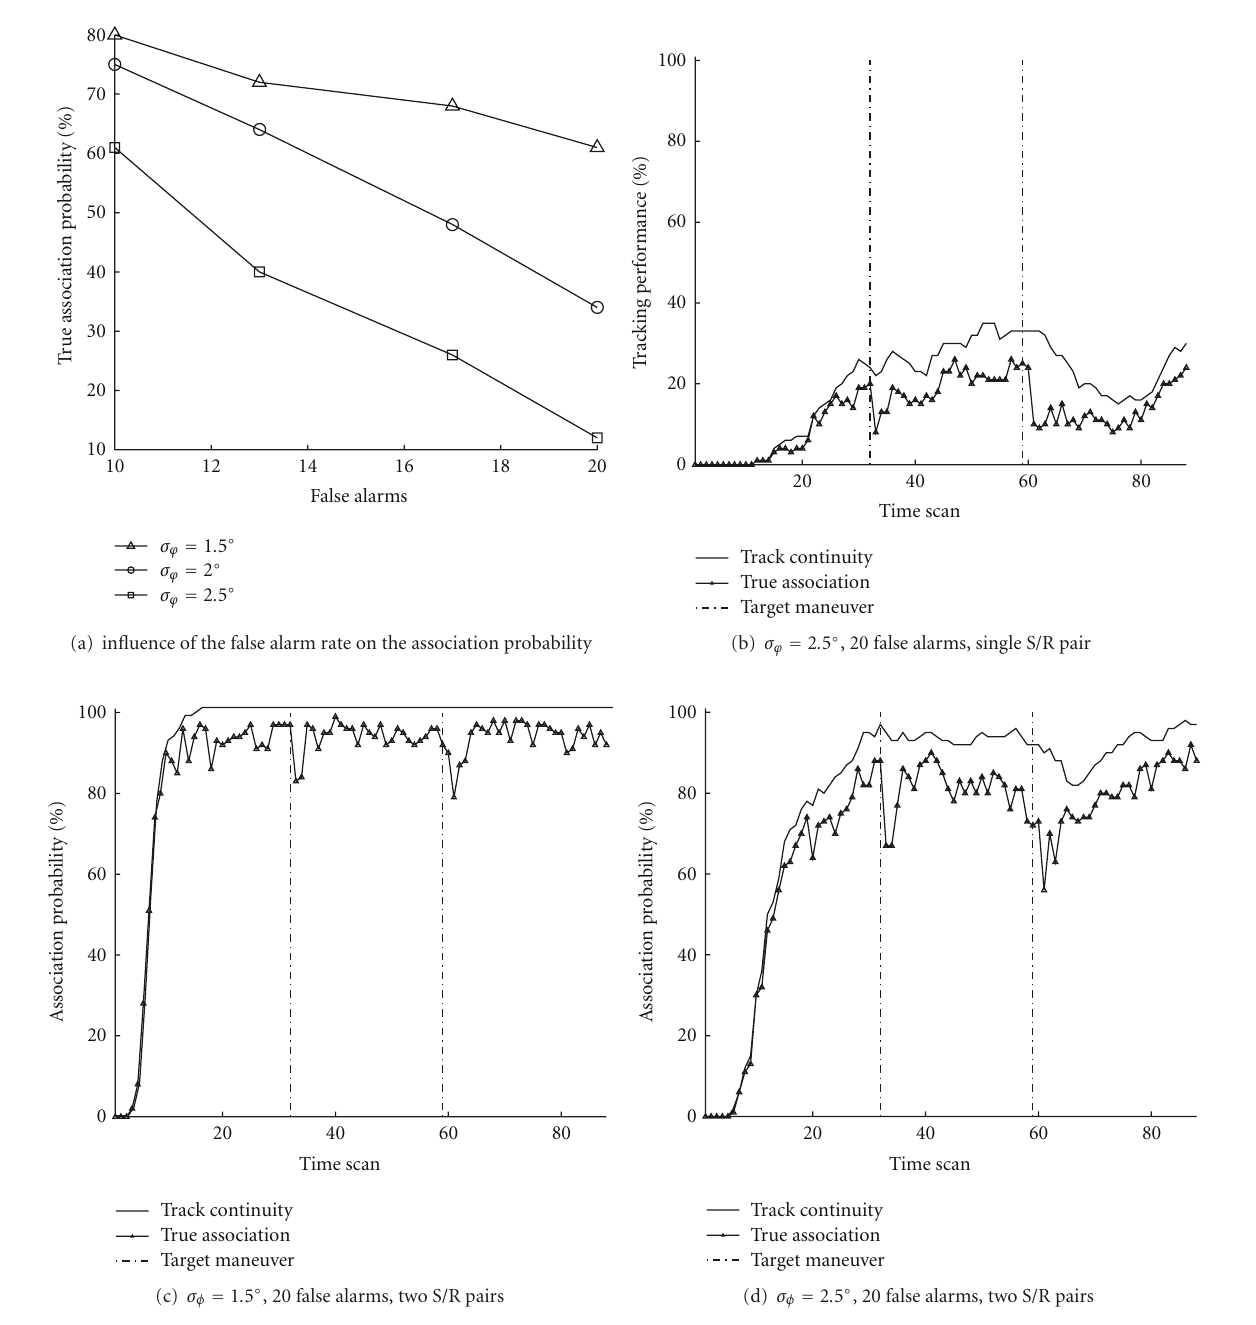
Figure 21: Impact of the number of false alarms and azimuth accuracy on tracking performance. In (a) and (b) only one S/R pair in (c) and (d) two S/R pairs are